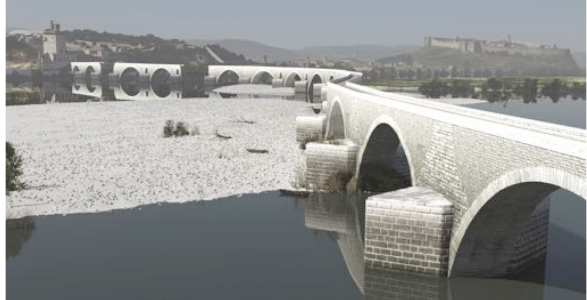
Figure 11. The final render of the Bridge, from Avignon side, in its hypothetical state in 1650.